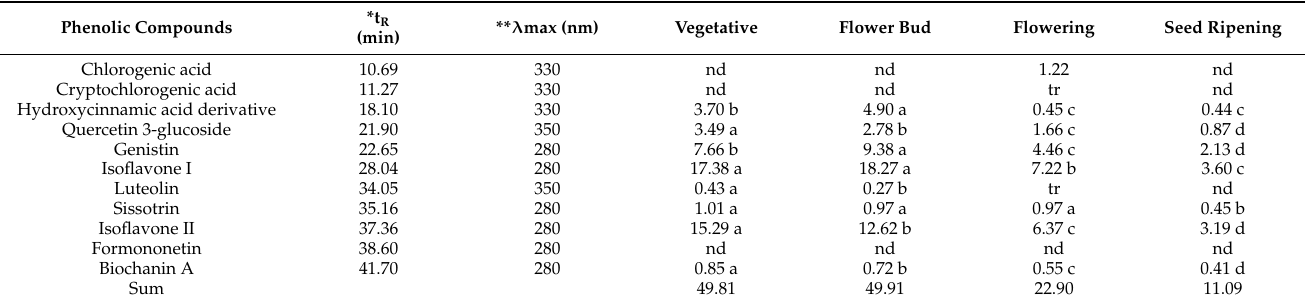
Table 6. HPLC analysis of individual phenolic compounds (mg g − 1 DM) in Trifolium subterraneum